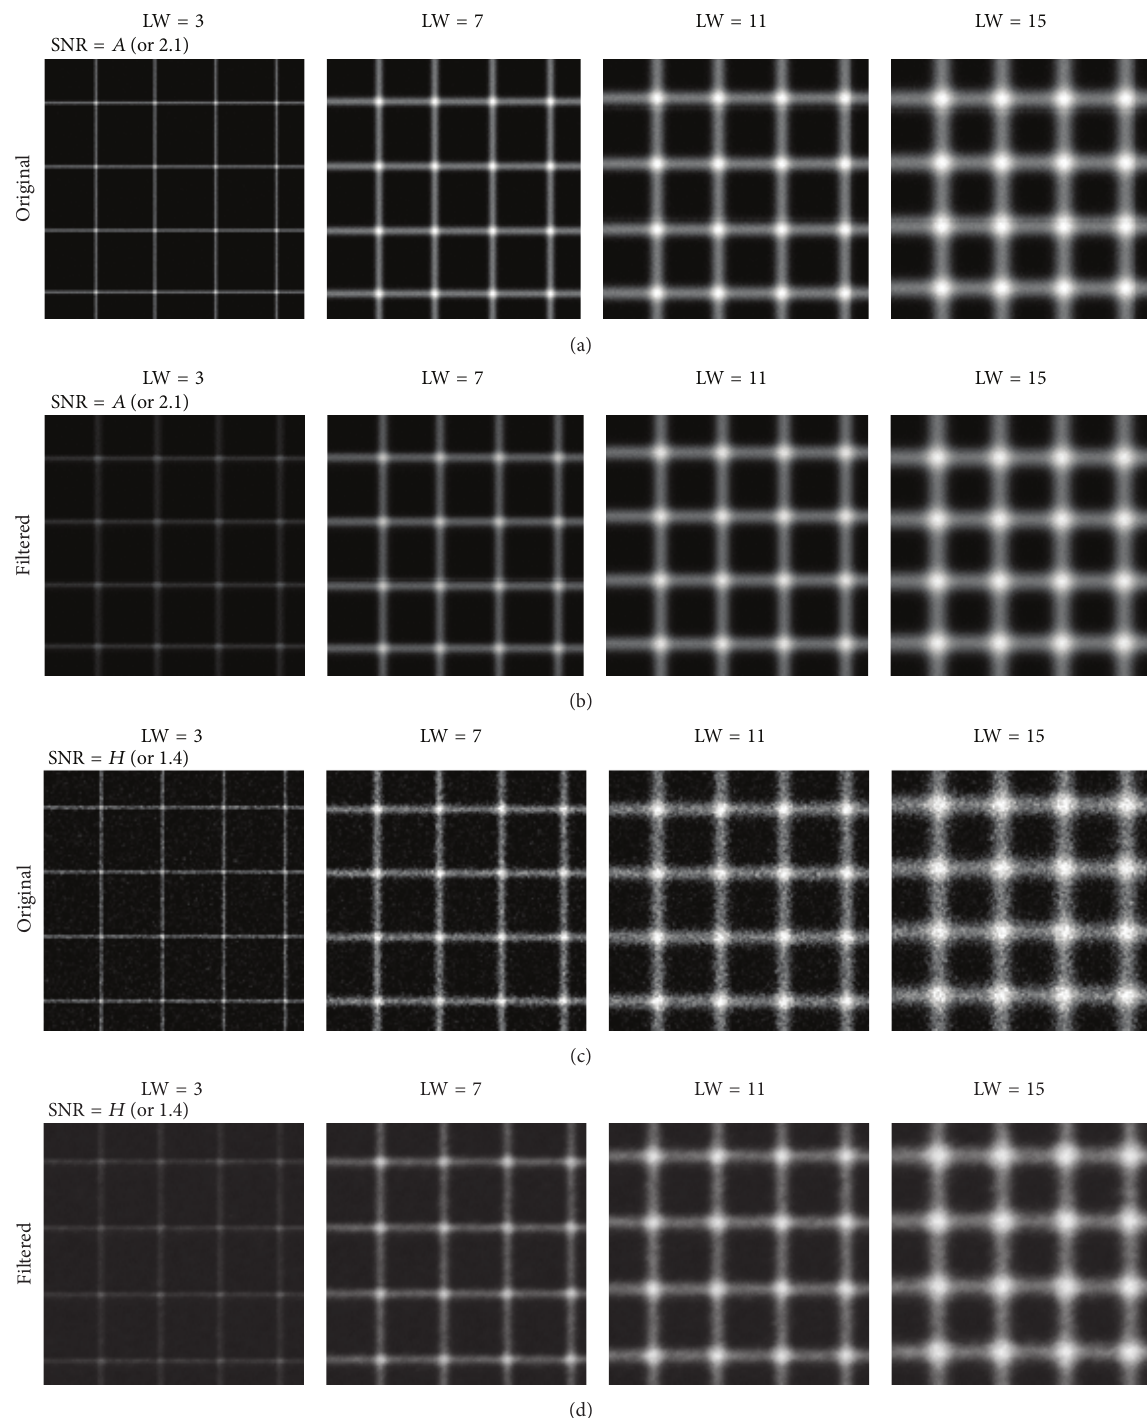
Figure 13: Original (a and c) and mean-filtered images (b and d) for selected SNRs and different line widths at each SNR.